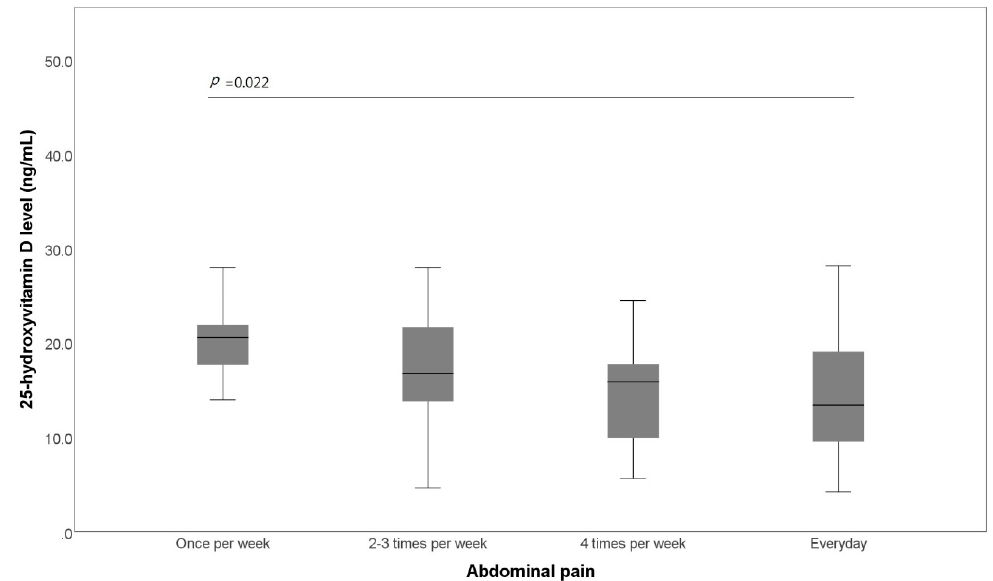
Figure 1. Box plot of the comparison of the 25-hydroxyvitamin D level and abdominal pain. Patients with irritable bowel syndrome are stratified by the frequency of abdominal pain. Regardless of the type of IBS, the frequency of defecation was not related to the average 25-OHD level. The mean 25-OHD level was related to symptom relief after defecation (Figure 2). The 25-OHD level of the group whose symptoms were relieved to some degree after defecation was significantly lower than that of those whose symptoms were completely relieved after defecation (12.70 ± 5.27